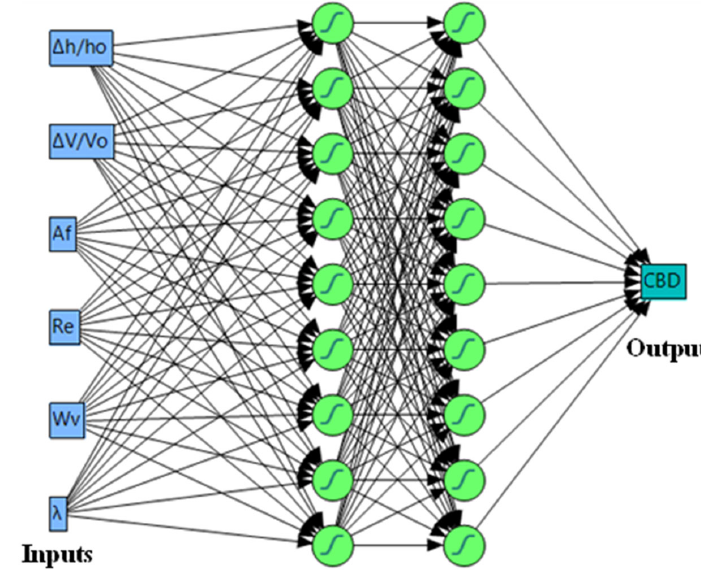
Figure 4. Depiction of the architecture of the feed-forward ANN model.